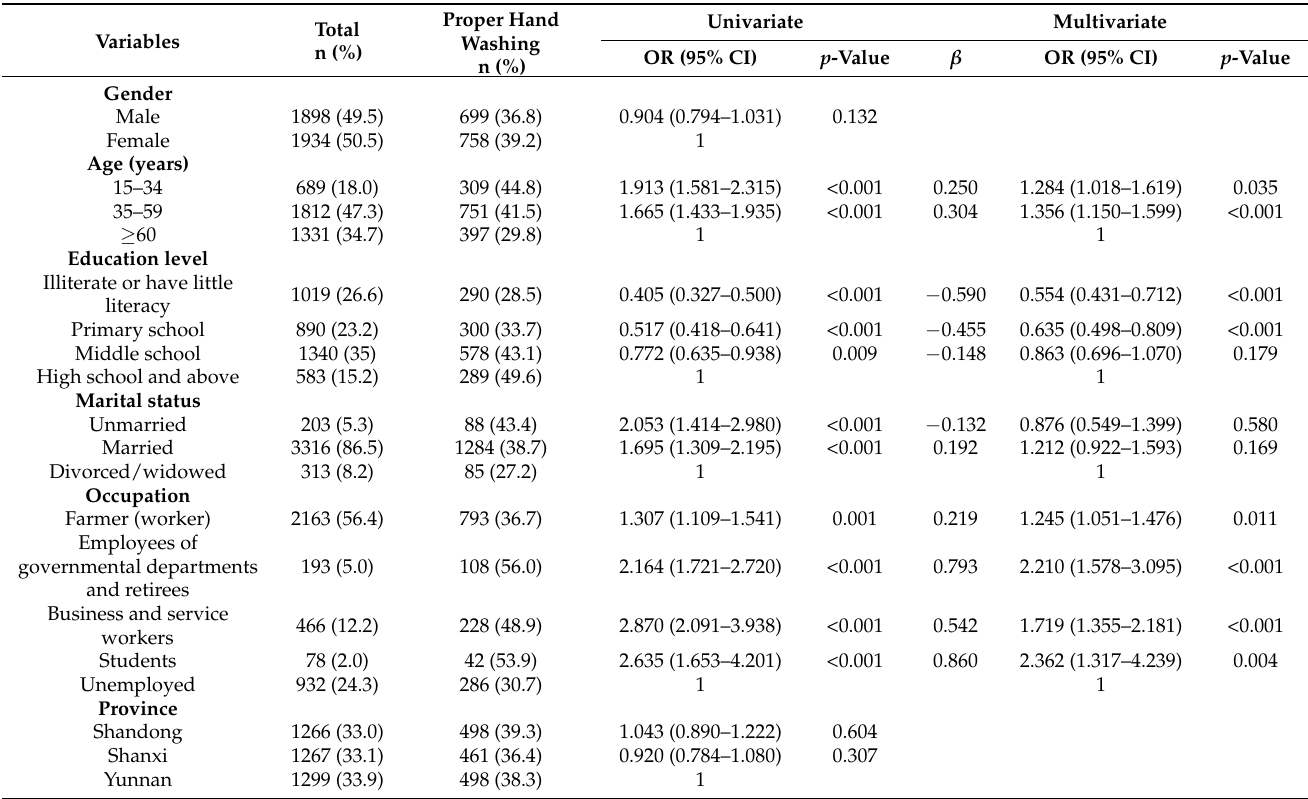
Table 7. Logistic regression analysis for influencing factors of proper handwashing (n =